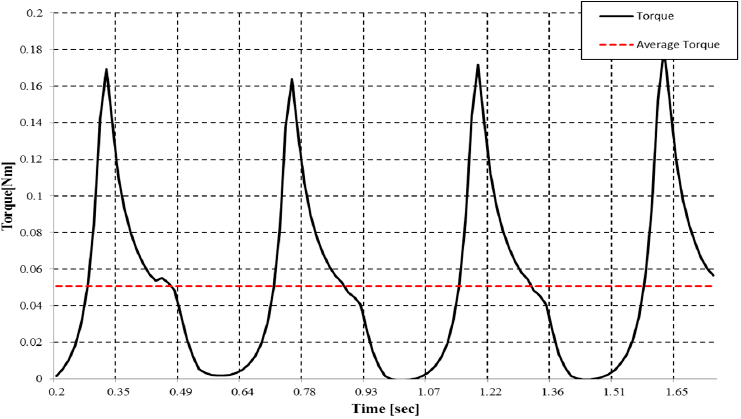
Figure 13. Torque graph through analysis.